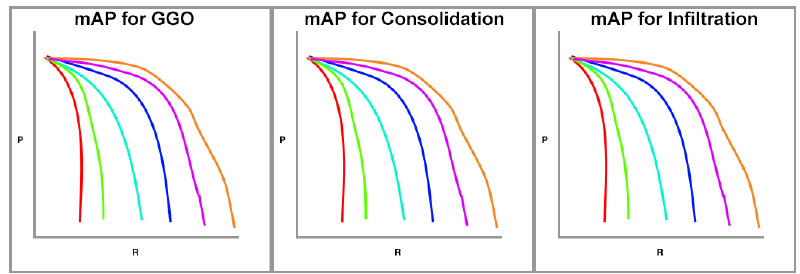
Figure A3. AP on each lesion performance